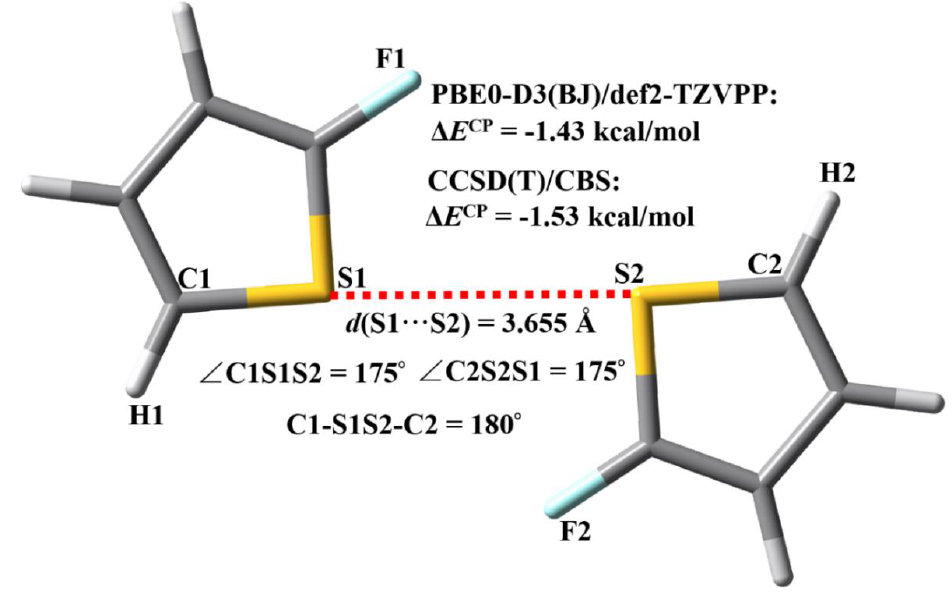
Figure 3. The PBE0-D3(BJ)/def2-TZVPP optimized geometries, PBE0-D3(BJ)/def2-TZVPP